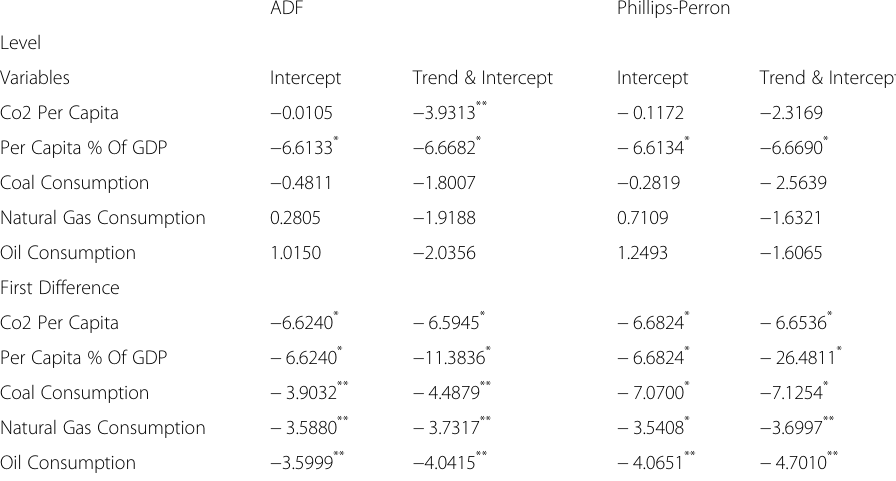
Table 1 Unit Root Test